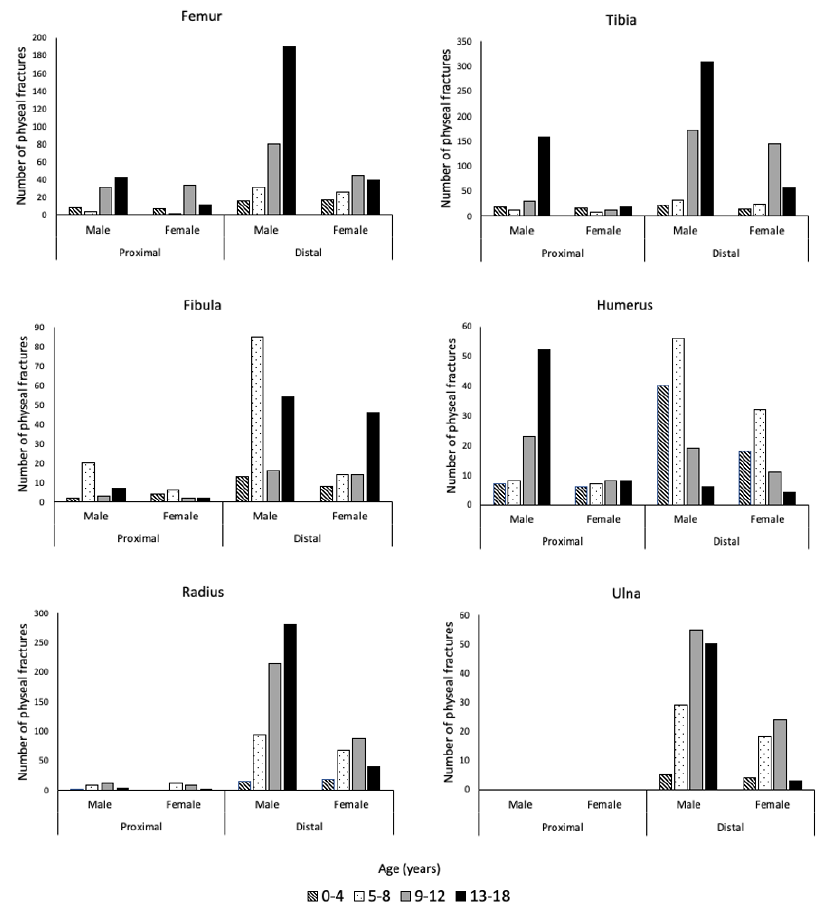
Figure 5. The number of physeal fractures for the femur, tibia, fibula, humerus, radius, and ulna, separated by sex, anatomic location (proximal and distal), and age group.